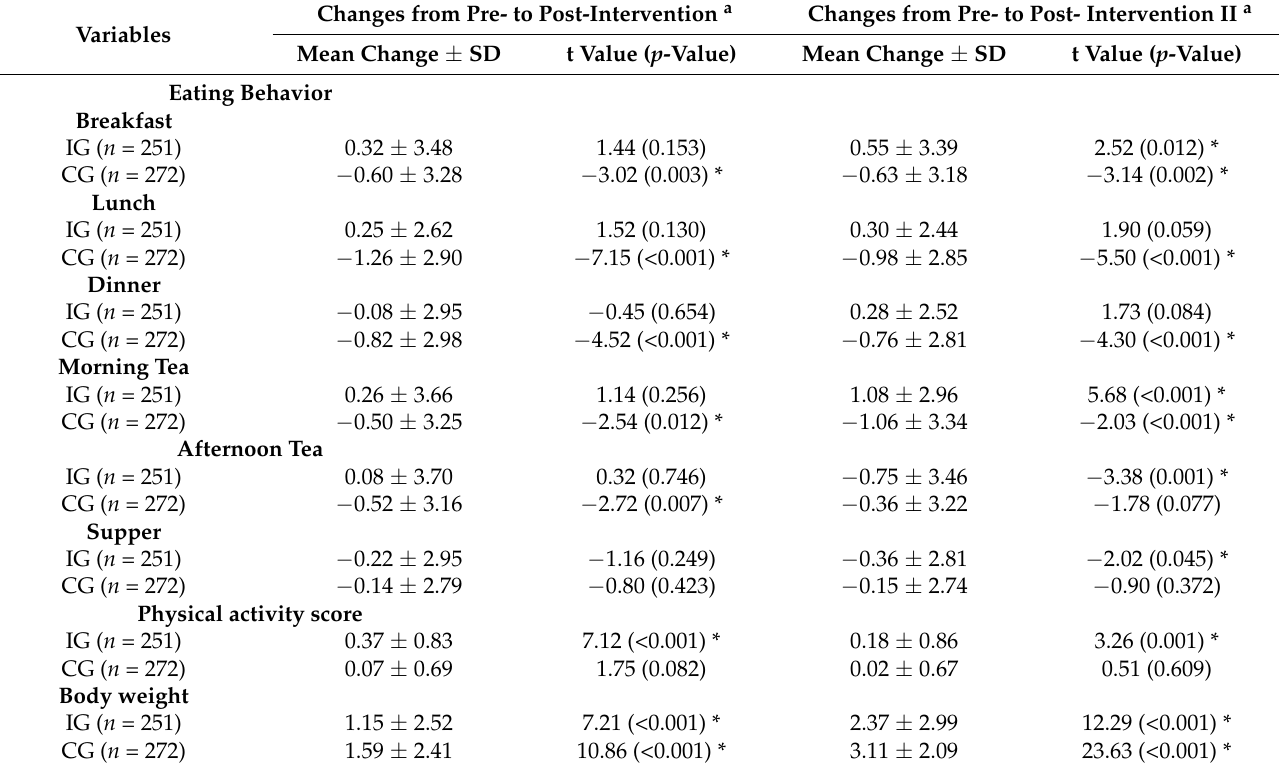
Table 2. Changes in eating behaviors, physical activity, BAZ, and cognitive performance from pre-intervention to post- intervention and at 3-month